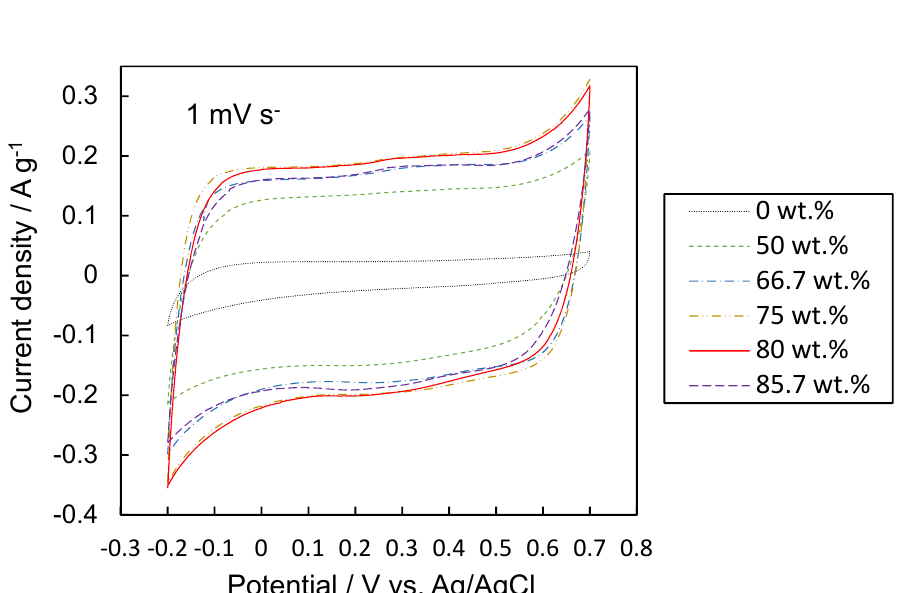
Figure 7. CV graphs of the samples. The capacitance values were calculated from the CV data. The capacitance per gram at 1 mV s − 1 as the function of the amount of KOH added for activation is shown in Figure 8a. It can be seen that the capacitance values largely increased with KOH activation. Therefore, KOH activation is effective for the increment of the capacitance value. The capacitance values per gram at 1 mV s − 1 as the function of the S BET value are shown in Figure 8b. The capacitance values were improved with the increment of surface area associated with KOH activation. The maximum capacitance value of 200 F g − 1 was observed at a surface area of 2500 m 2 g − 1 and compares favorably to respective values from graphene materials reported earlier [46,47]. However, further enhancement of the surface area was ineffective for the improvement of the capacitance value. The capacitance values per area in correlation to the S BET values are drawn in Figure 8c. The maximum capacitance value per